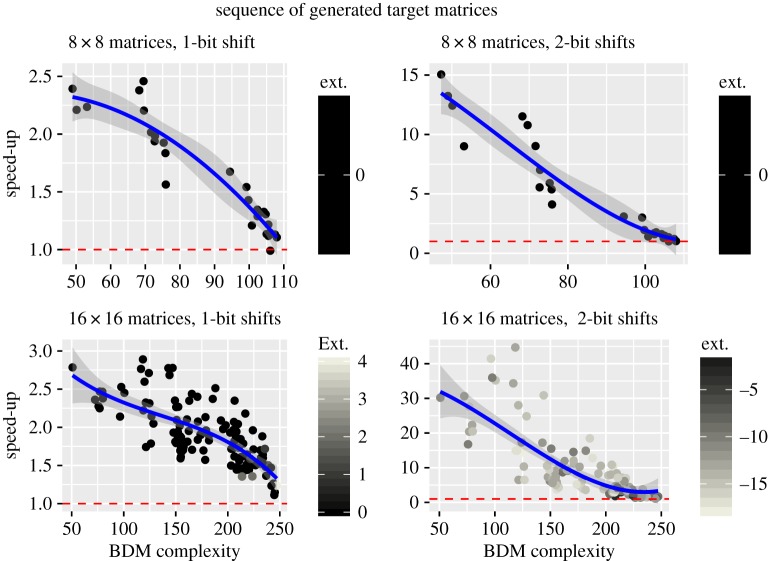
The Speed-Up quotient is defined as δ = Su/SBDM, where Su is the average number of steps it took to reach convergence under the uniform strategy and SBDM for BDM, and ‘ext.’ is the difference Eu − EBDM where each factor is the number of extinctions obtained for the universal and BDM distribution, respectively. In the case of an extinction, the sample was not used to compute the average number of steps. The red (dashed) line designates the Speed-Up threshold at y = 1: above this line we have positive speed-up and below it we have negative speed-up. The blue (continuous) line represents a cubic fit by regression over the data points.